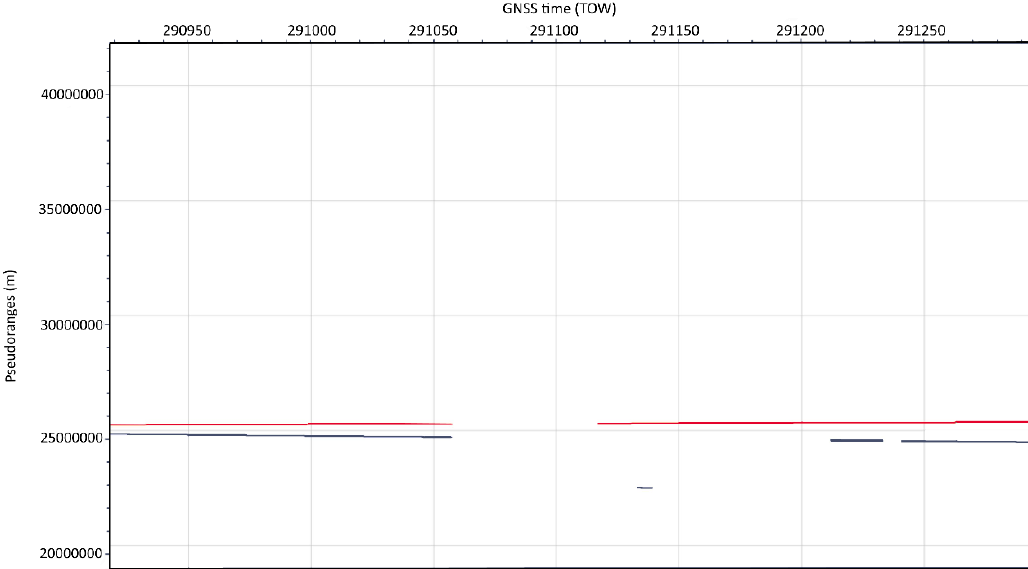
Figure 12. Pseudorange time plot of the spoofed GPS PRN18 (in blue) tracked between TOWs 291,133 and TOWs 291,139 (compared to consistent pseudorange of true GPS PRN25 in red).